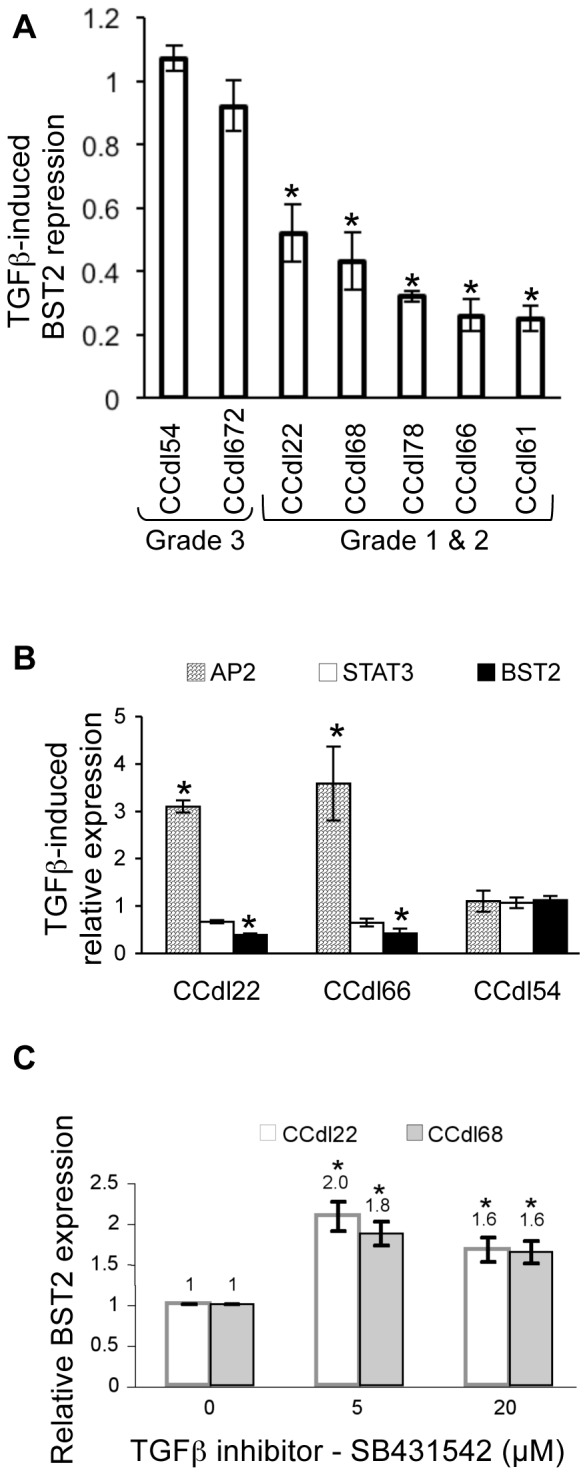
Regulation of BST2 expression by TGFβ in breast cancer cells.
A. Reduction in baseline BST2 expression detected in 5 grade 1 & 2 cell lines after 24 hr TGFβ (4 ng/ml) treatment. Each QPCR reaction was carried out in triplicate, and values normalized to ACTB expression and to vehicle-only controls. Asterisks represent statistically significant differences (p<0.01) between untreated and TGFβ-treated samples. B. TGFβ-induced shift in AP2 and STAT3 transcript levels under the same treatment conditions employed in panel A. BST2 reduction in grade 1 (CCdl22) & 2 (CCdl66) cell lines is accompanied by a decline in STAT3 levels, while AP2 transcripts increase significantly. No significant changes were observed in grade 3 (CCdl54) cells. Each assay was done in triplicate. Asterisks indicate a significant difference (p<0.01) between untreated and TGFβ-treated samples. C. Inhibition of the TGFβ pathway with 24 hr SB-431542 treatment increased BST2 expression in grade 1 cell lines (CCdl22, CCdl68). Data acquired in triplicate shows significant differences (p<0.01) between test and vehicle-only cell samples, indicated by asterisks.